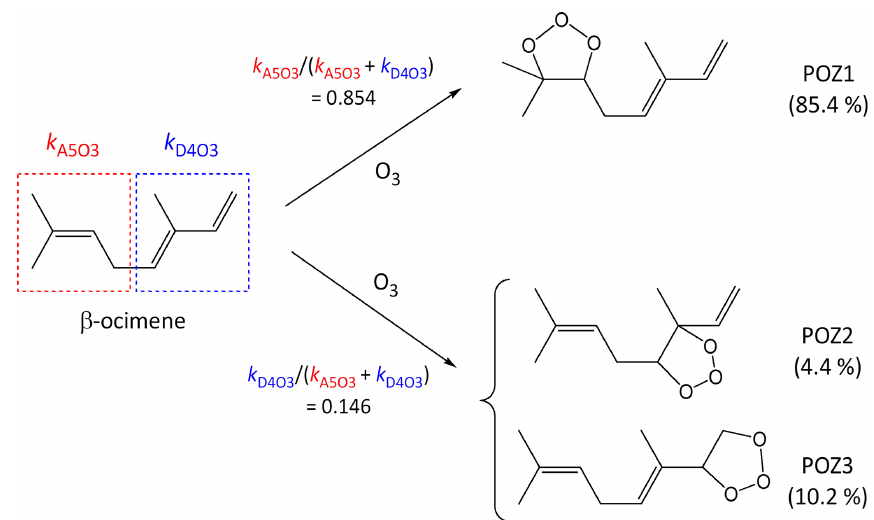
Figure 6. Schematic of the concerted addition of O 3 to β -ocimene to form primary ozonides (POZs), showing the calculated contributions of the different pathways at 298K, based on the reported estimation methods (see Sect. 5).